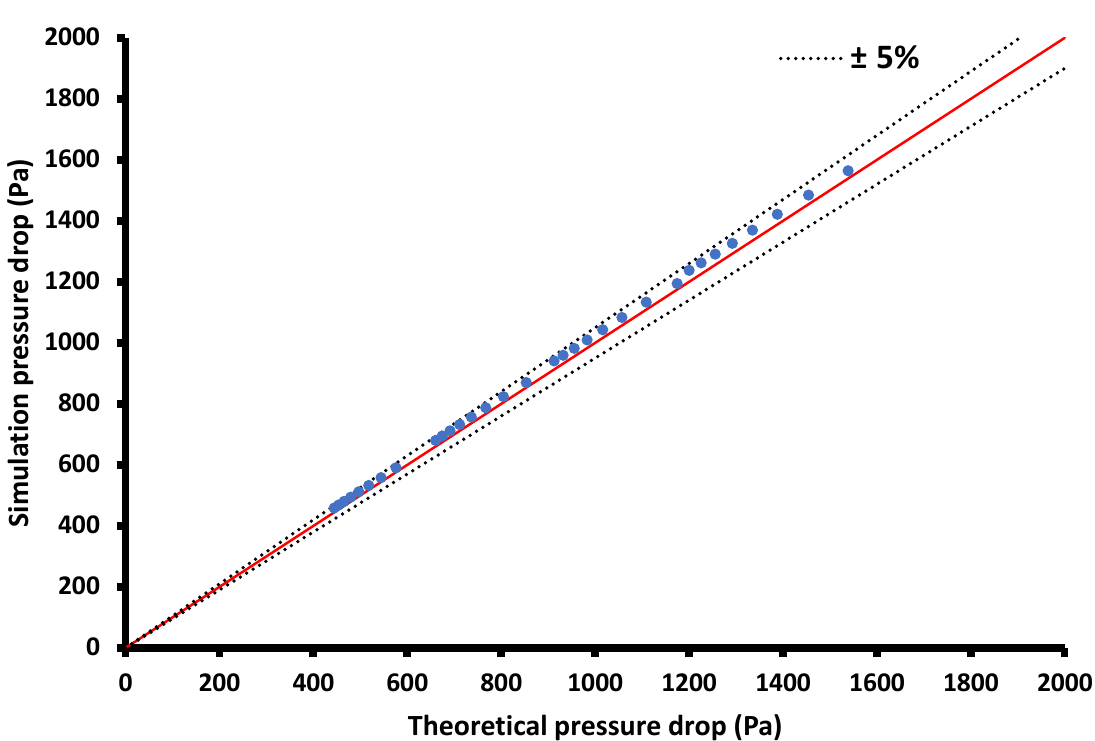
Figure 6. Deviations in the pressure drop between simulation studies and theoretical calculations.